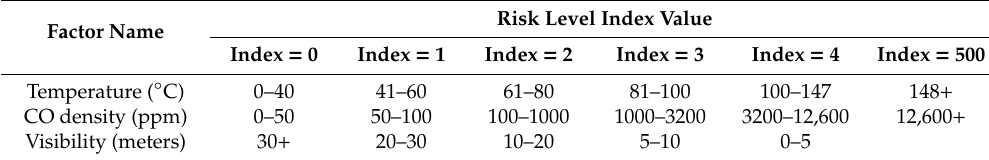
Table 1. Factors related to fire and their risk level index (RLI)